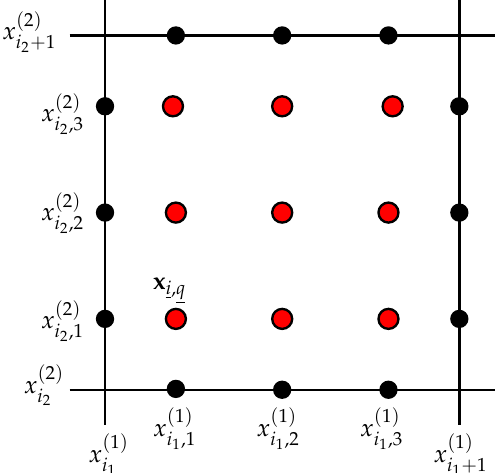
(cid:2) (cid:3) × (cid:2) (cid:3) ( 1 ) ( 1 ) ( 2 ) ( 2 ) x x , x , x , i 1 i 1 + 1 i 2 i 2 + 1 ( (cid:96) ) , with i (cid:96) , q (cid:96)